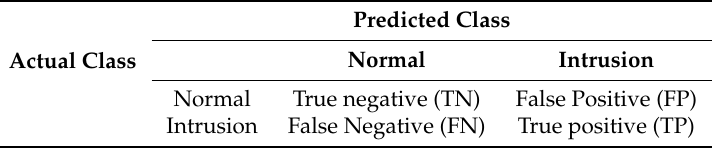
Table 6. Confusion matrix of an IDS for evaluation